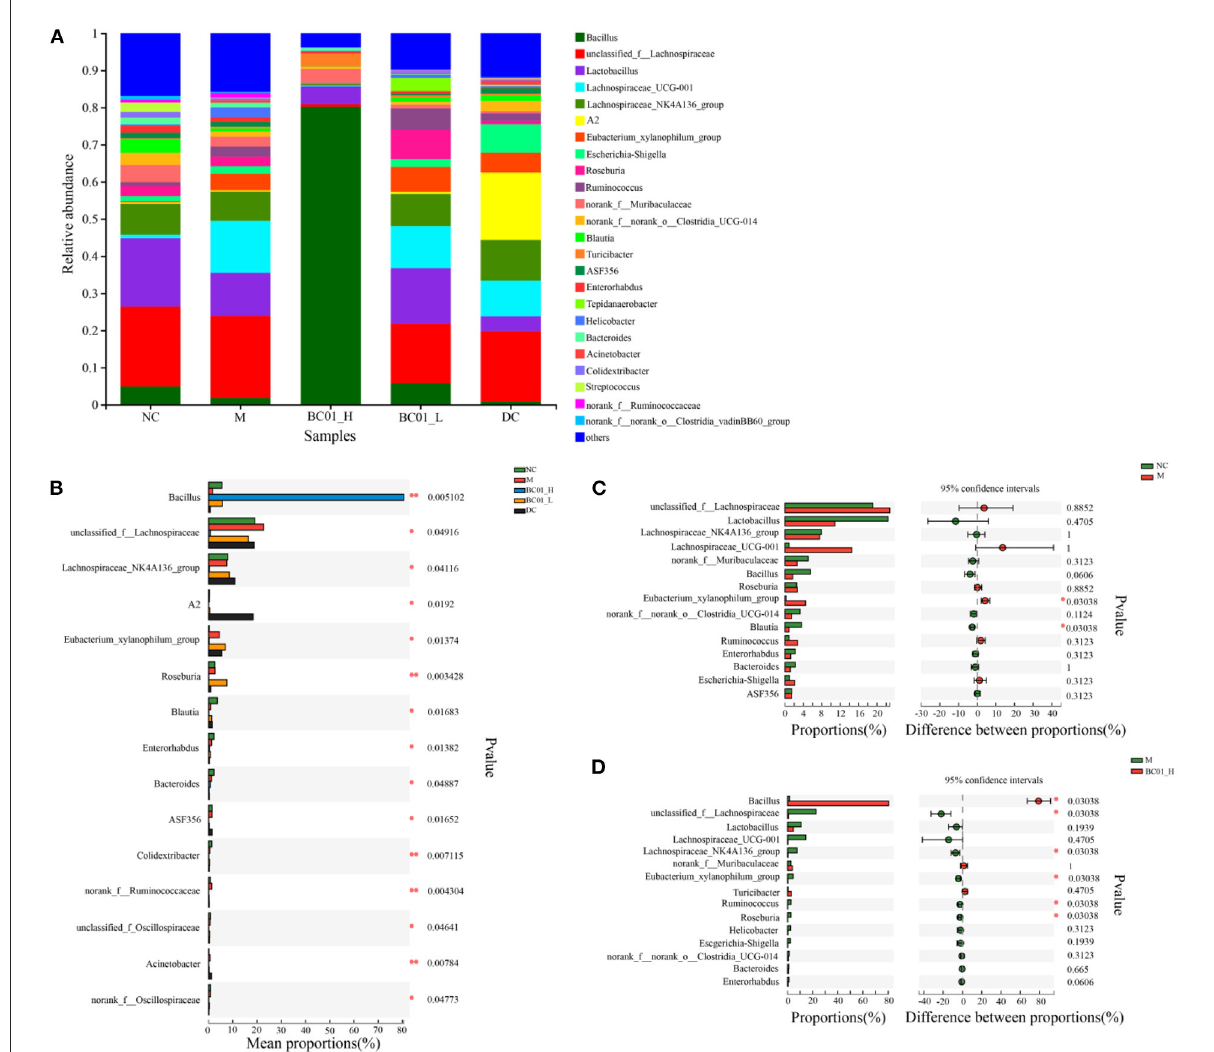
FIGURE7 Effects of BC01 on the intestinal microbial composition and structure in the constipated mice. (A) Changes in the relative abundance of gut microbiota at the genus level. (B) Comparison of the gut microbiota composition between the experimental groups at the genus level. (C) Microflora comparison between the NC and M groups at the genus level. (D) Microflora comparison between the M and BC01-H groups at genus level. The p values are shown on the right. NC, normal group; M, constipation model group; DC, bisacodyl control group; BC01-H,